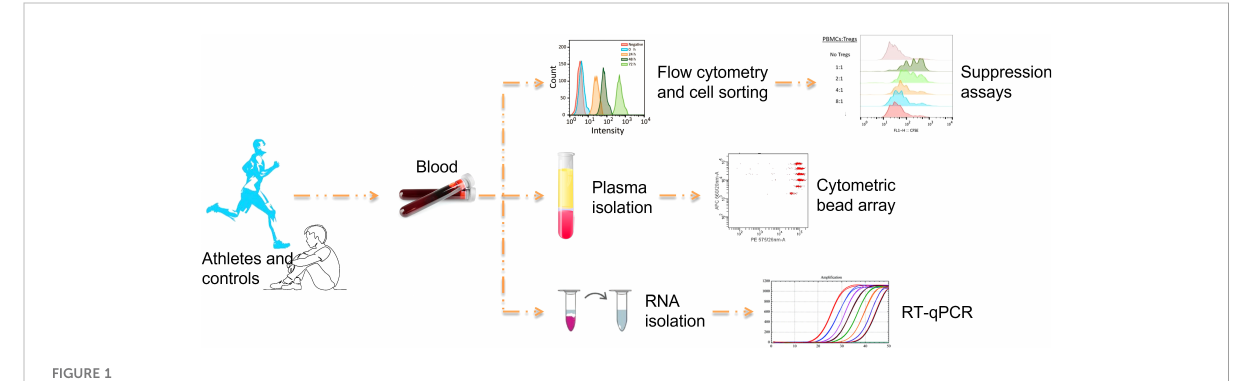
FIGURE 1 The experimental design of the